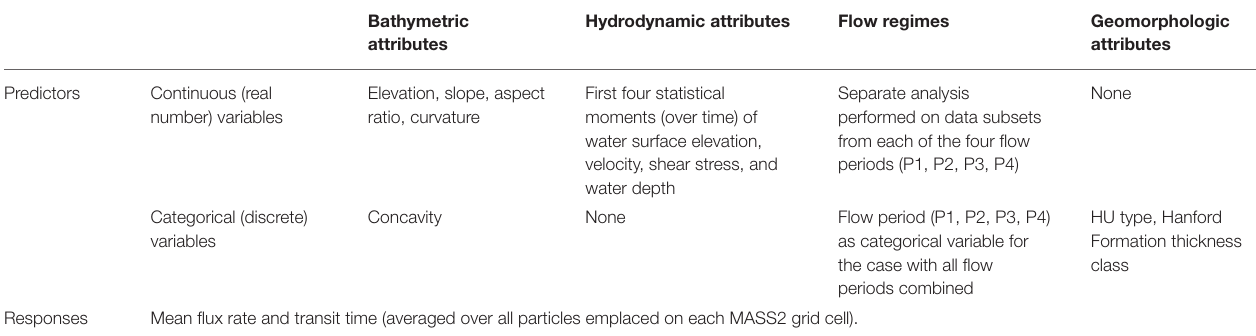
TABLE 3 | Summary table of the ML model predictors and responses for the base